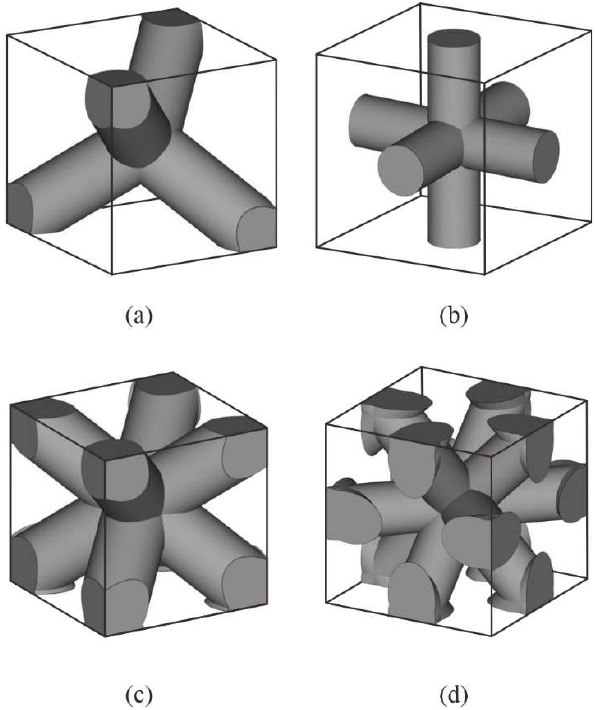
Figure 1. Graphic models of dendritic lattices in cubic unit cells. Cylindrical lattices were connected at coordination numbers of 4, 6, 8 and 12, as shown in ( a – d ), respectively. These units were continuously copied and parallel-translated in three dimensions to create the lattice propagations.